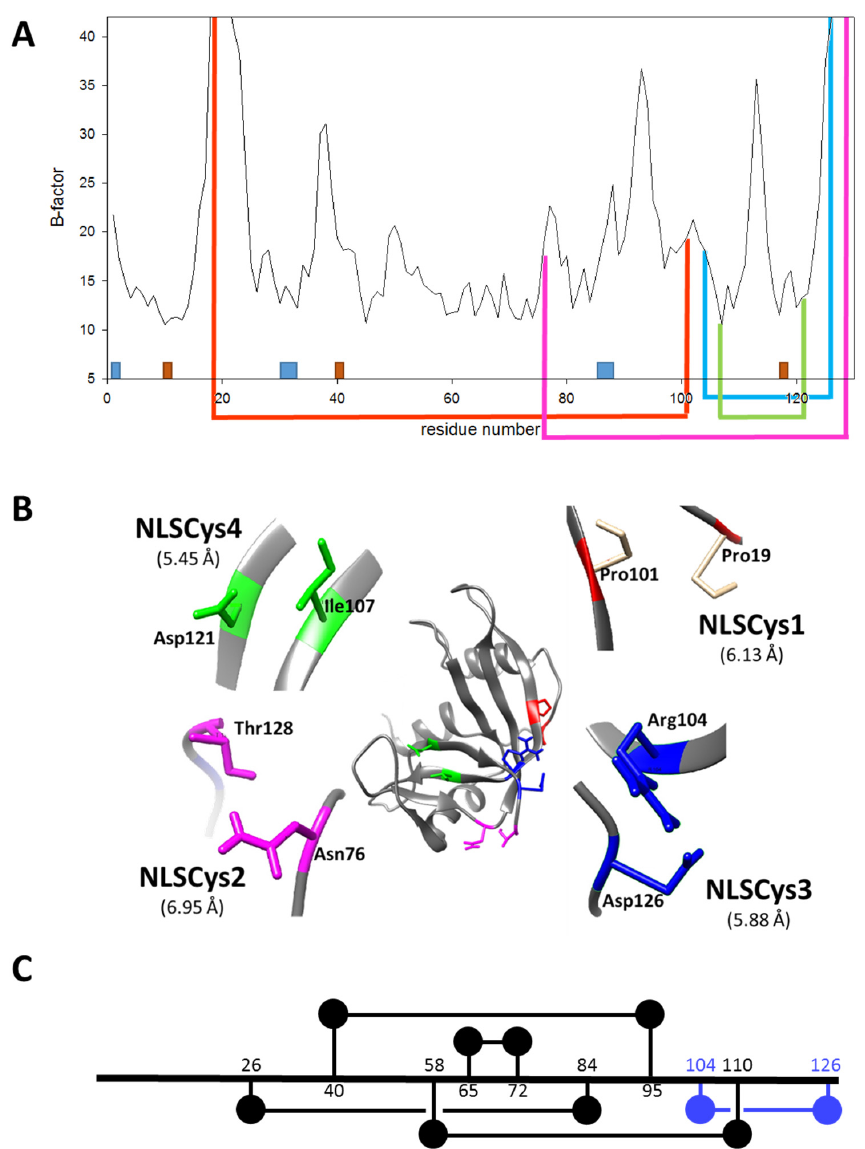
Figure 1. Design of the ND-RNase variants. ( A ) Location of the engineered additional disulfide bonds in the primary sequence of the ND-RNase. B-factor plot for each residue of the sequence (pdb 1dza). Orange boxes show the position of the catalytic triad of the enzyme (His12, His119 and Lys41) and blue boxes those of the residues important for α -importin binding (Lys1, Arg31–33 and Arg89–91). Engineered disulfide bonds are indicated under the plot by lines connecting the created cysteines in NLSPE5Cys1 (red), NLSPE5Cys2 (pink), NLSPE5Cys3 (blue), and NLSPE5Cys4 (green). ( B ) Ribbon diagram of the modeled structure of PE5 ND-RNase and detailed disposition of the different pairs of residues substituted by cysteine in each variant. ( C ) Amino acid connectivity of the five disulfide bonds in the most stable variant NLSPE5Cys3. Black lines correspond to the disulfide bonds already present in the parental RNase and blue line to the new introduced disulfide bond.